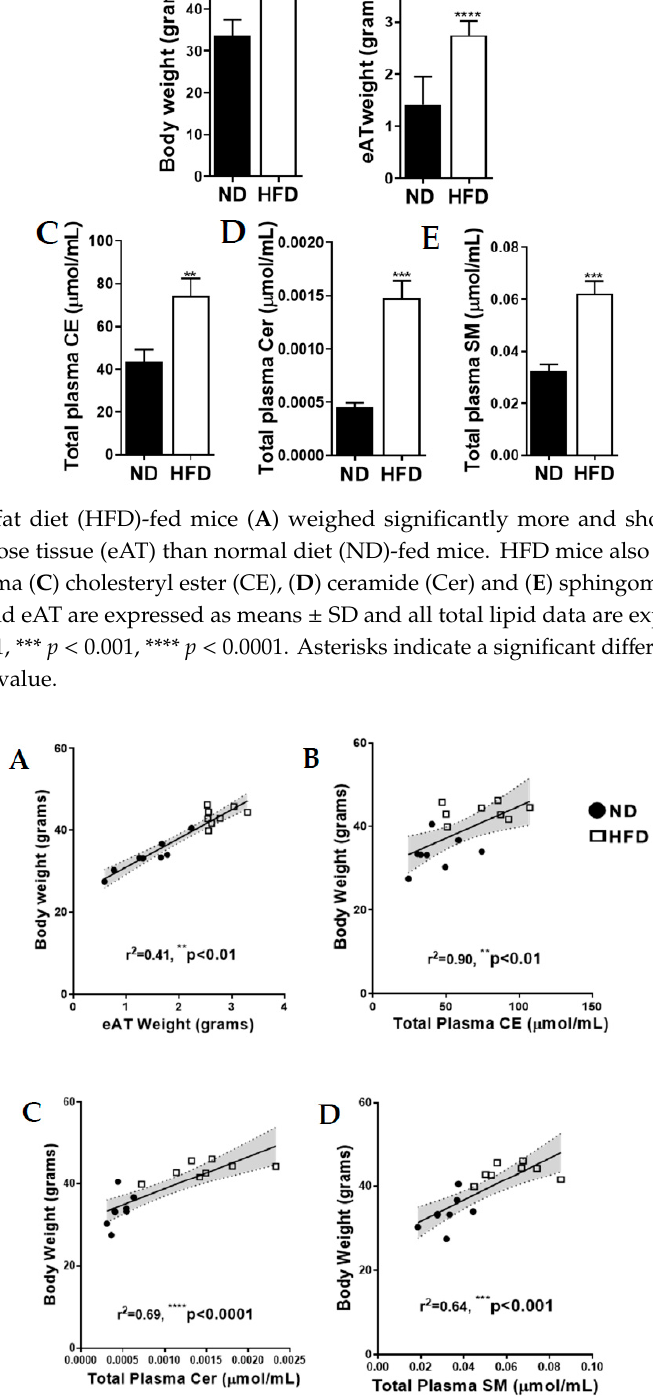
Figure 2. Correlation between mouse body weight and ( A ) epididymal adipose tissue (eAT) and total plasma ( B ) cholesteryl esters (CE), ( C ) ceramides (Cer), and ( D ) sphingomyelins (SM). The grey-shaded regions represent the 95% confidence interval. Asterisks indicate a significant di ff erence compared to the matched ND